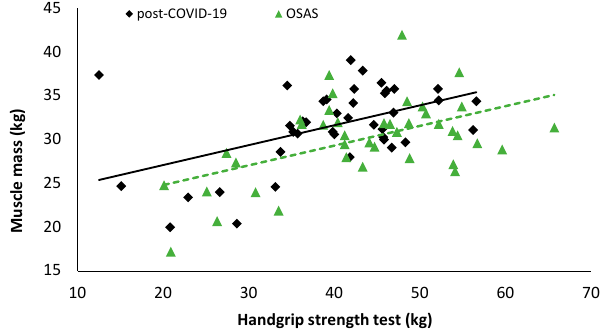
Figure 4. Correlation analysis results between the handgrip strength test and distance during the 6MWT (post-COVID-19: r = 0.540, p < 0.001; OSAS: r = O.322, p = 0.044). In patients with OSAS, statistically significant correlations were detected between the distance covered during the 6MWT and leg fatigue before the 6MWT (r = − 0.407, p = 0.009), heart rate during the 6MWT (4th minute: r = 0.344, p = 0.030; 5th minute: r = 0.400, p = 0.011; 6th minute: r = 0.349, p = 0.027), differences in heart rate (baseline to end of the 6MWT: r = 0.416, p = 0.008), and O 2 saturation during the 6MWT (2nd minute: r = 0.384, p = 0.015; 4th minute: r = 0.315, p = 0.048). In post-COVID-19 patients, statistically significant correla- tions were detected between the 6MWT and muscle mass (r = 0.317, p = 0.046,), Δ chest (r = 0.333, p = 0.036), and leg fatigue at the end of the 6MWT (r = − 0.362, p = 0.022), dyspnea in the baseline (r = − 0.478, p = 0.002) and at the end of the 6MWT (r = − 0.375, p = 0.017), and O 2 saturation during the 6MWT (4th minute: r = − 0.390, p = 0.014; 5th minute: r = − 0.319, p = 0.048). The results of multivariate analyses via BSLR are presented in Table 3. Table 3. Multivariate analyses via backwards stepwise logistic regression BSLR revealed several independent associations with COVID-19.